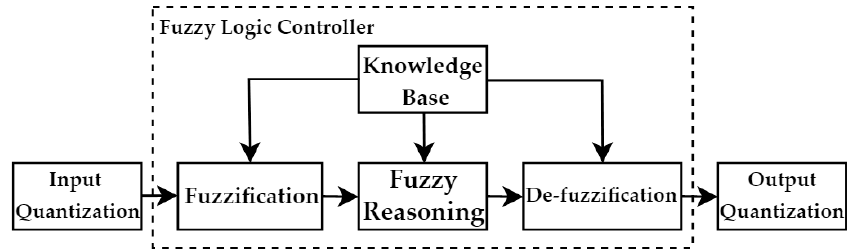
Figure 4. A block diagram of the principle of the fuzzy control.